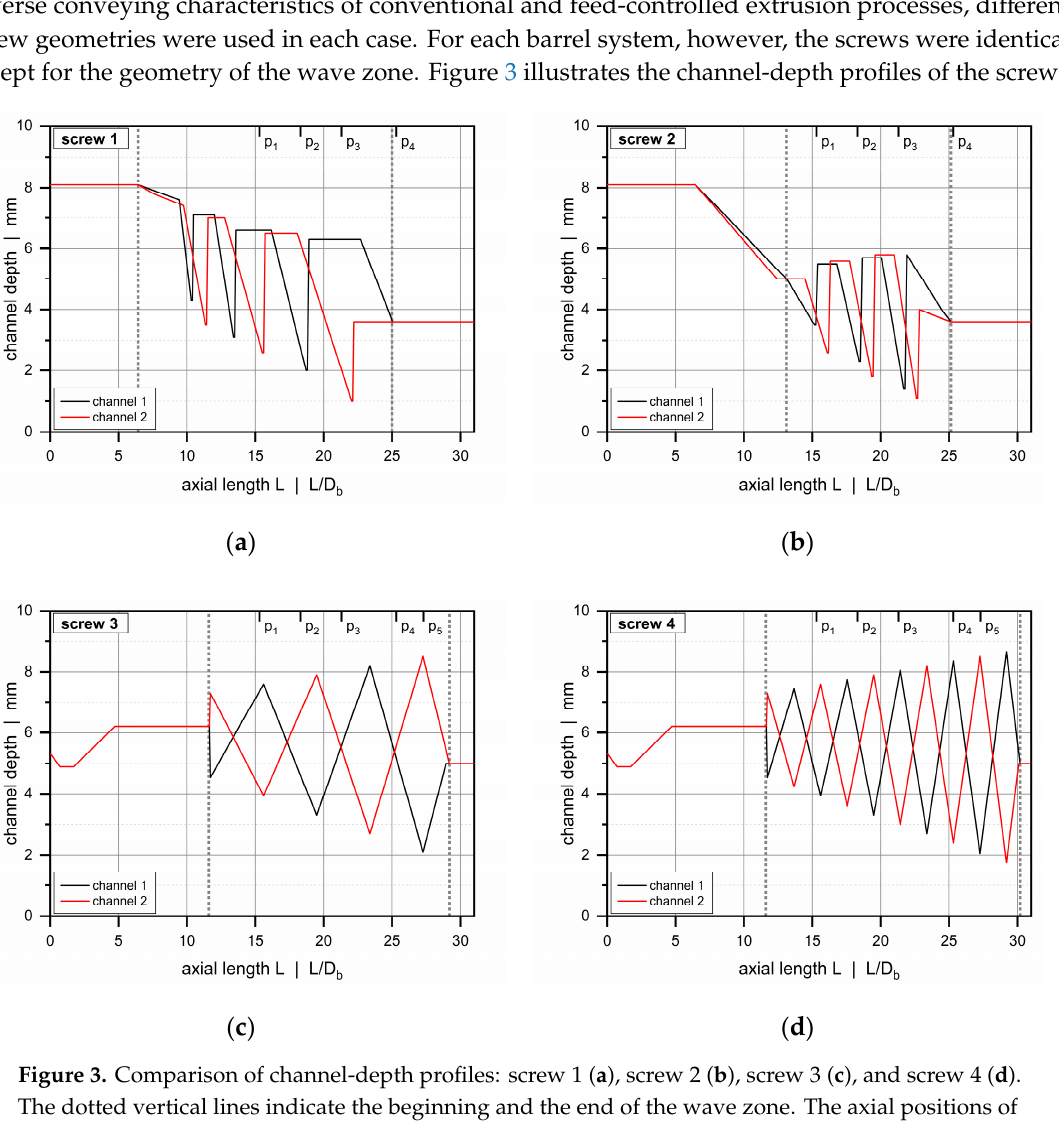
Table 3. Comparison of barrel designs.